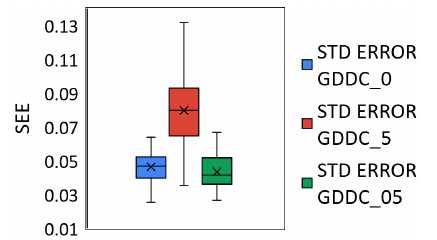
Figure 7 . SEE statistics as computed from the calibrated parabolic models relating local NDVI and GDD. They refer to the GDD_5, GDD_0 and GDD_05 profiles. Bottom-up: 5 th , 25 th , 50 th , 75 th and 95 th percentiles. Cross corresponds to the mean value.